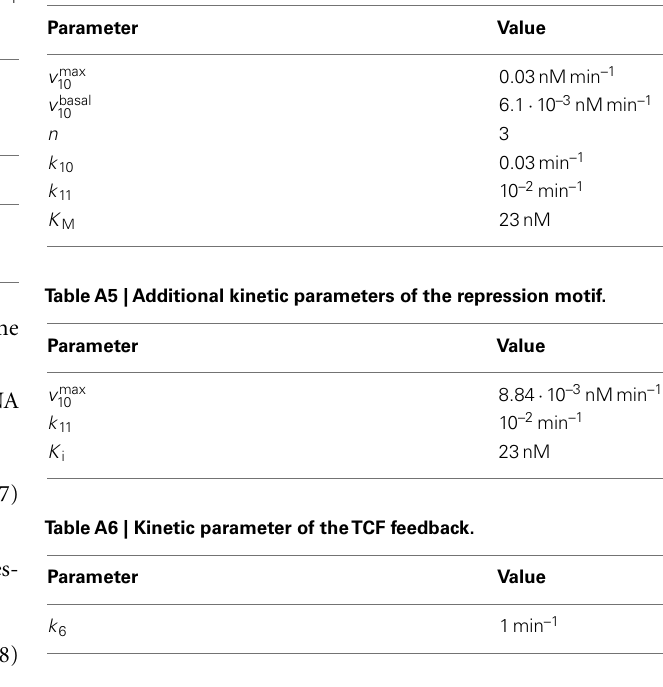
TableA4 | Kinetic parameters of the linear and Hill-type activation of the gene expression.